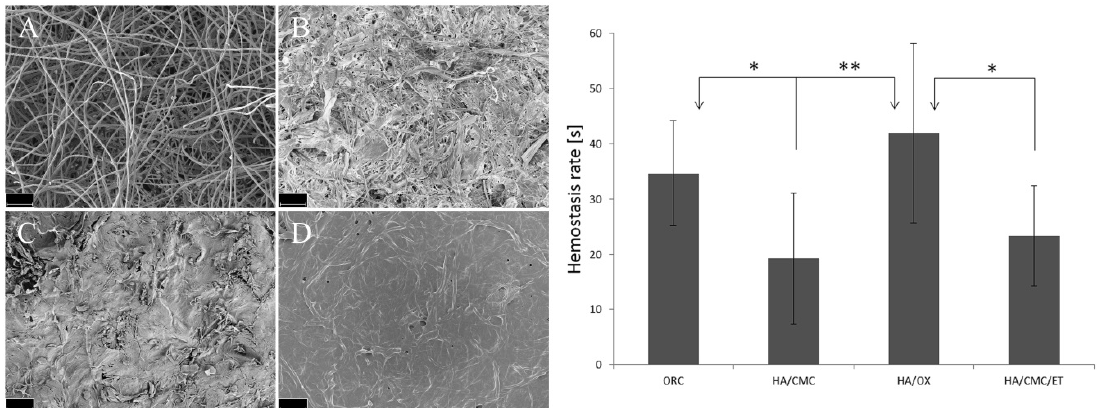
Figure 2. Left section—Morphology of all the hemostatic textiles under 100 × magnification; scale bars represent 100 µ m, ( A ) oxidized regenerated cellulose (ORC) textile, ( B ) hyaluronic acid and carboxymethyl cellulose (HA / CMC) textile, ( C ) hyaluronic acid and oxidized cellulose (HA / OX) textile, ( D ) HA / CMC / ET textile. Right section—time to hemostasis in seconds. Graph represents the means ± S.D. n = 10 for each study group. * p < 0.05, ** p < 0.01 in mutual comparison.